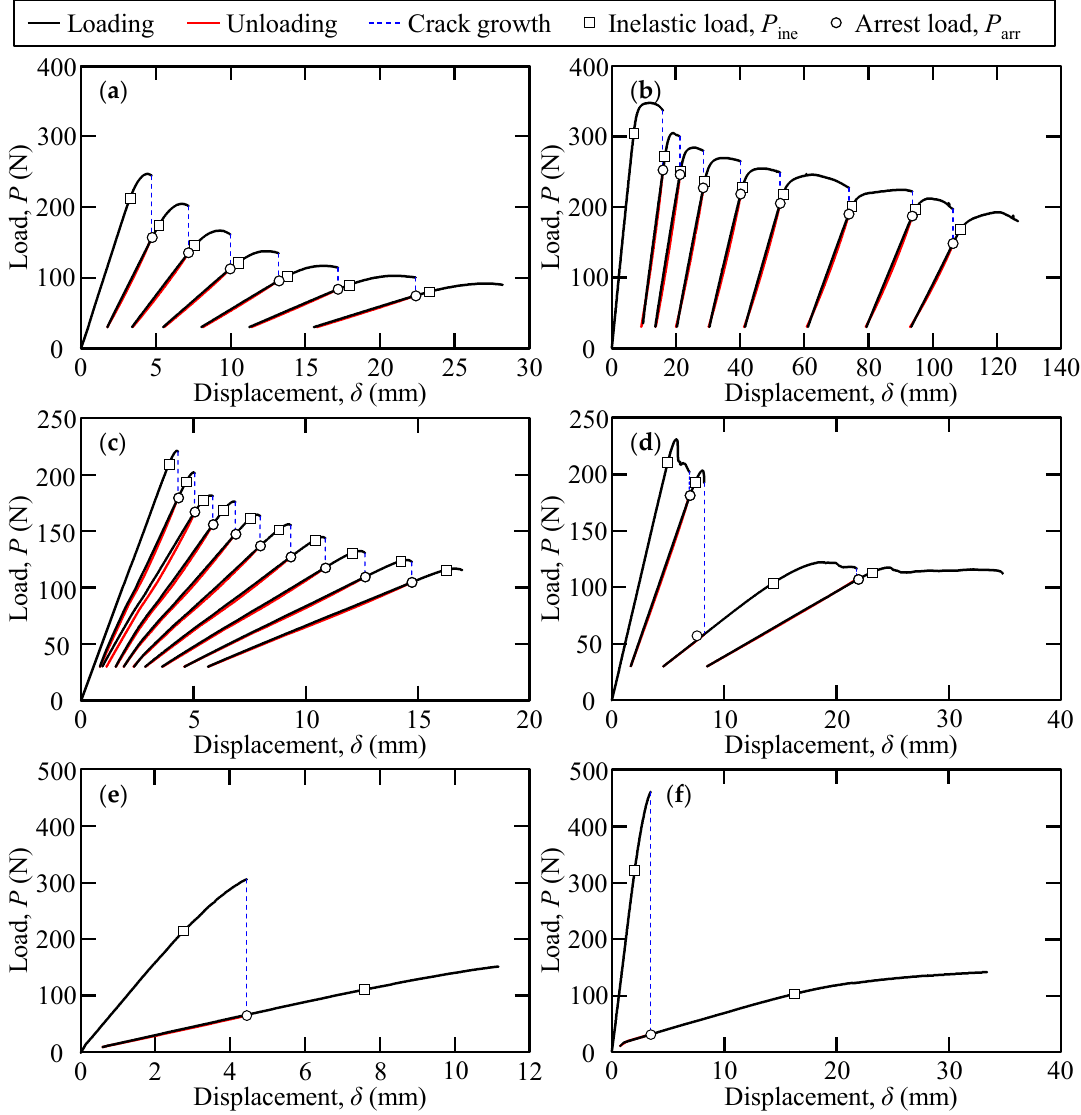
Figure 5. Load–displacement curves of the loading–unloading tests of ( a ) 0.3 mm thickness of Y618H, ( b ) 3.0 mm thickness of Y618H, ( c ) 0.3 mm thickness of Metal Lock, ( d ) 3.0 mm thickness of Metal Lock, ( e ) 0.3 mm thickness of Y611 Black S, and ( f ) 3.0 mm thickness of Y611 Black S.